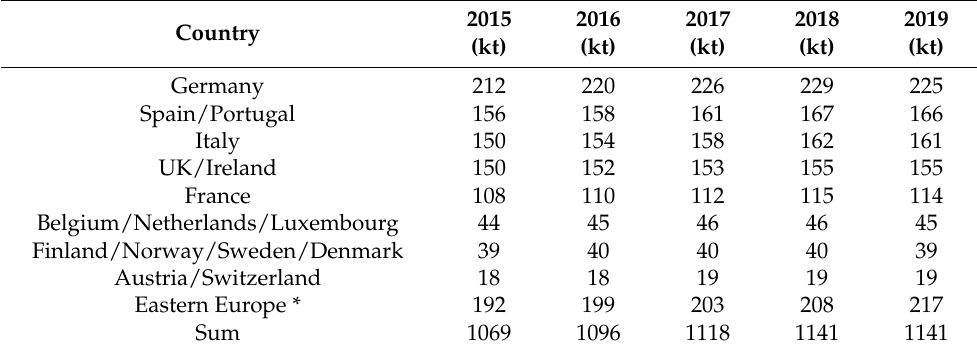
Table 2. Production of polymer composites in Europe, divided by countries [7].